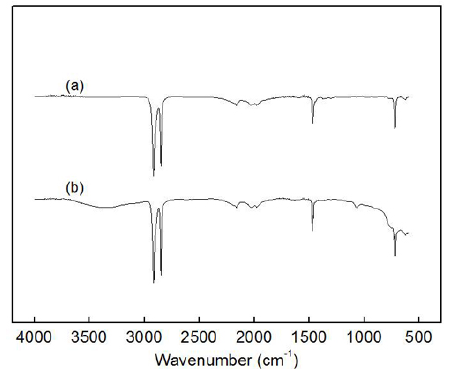
Figure 2. Fourier transform infrared (FT-IR) spectra of ( a ) insoluble parts after Soxhlet processing with hexane for poly(ethylene- ter -1-decene -ter - p - methylstyrene) (PEDM) and ( b ) polyethylene